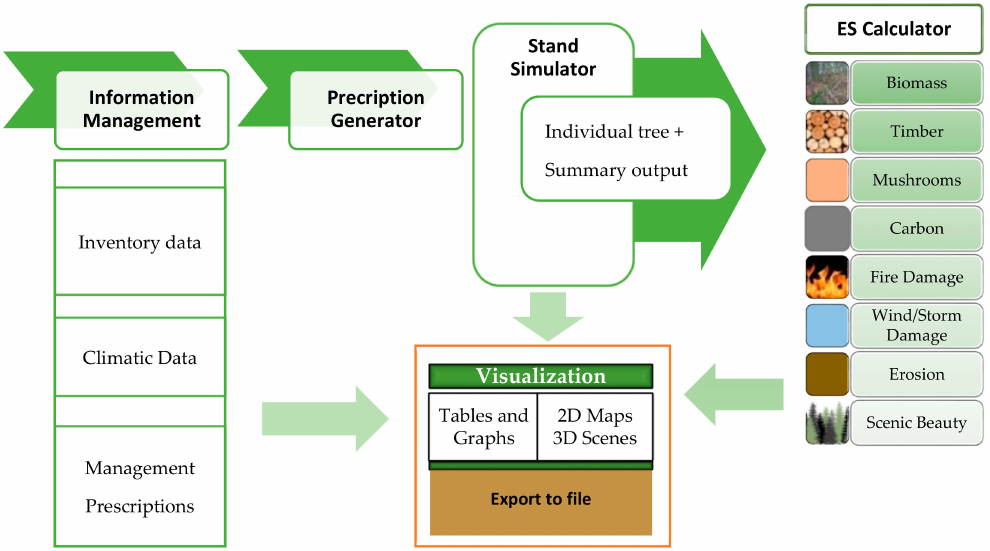
Figure 1. Conceptual design. Five consecutive components are illustrated clockwise: the information management component, the prescription generator component, the stand simulator, the Ecosystem Services (ESs) calculator component, and the visualization component. The arrows show the workflow and the interaction between the